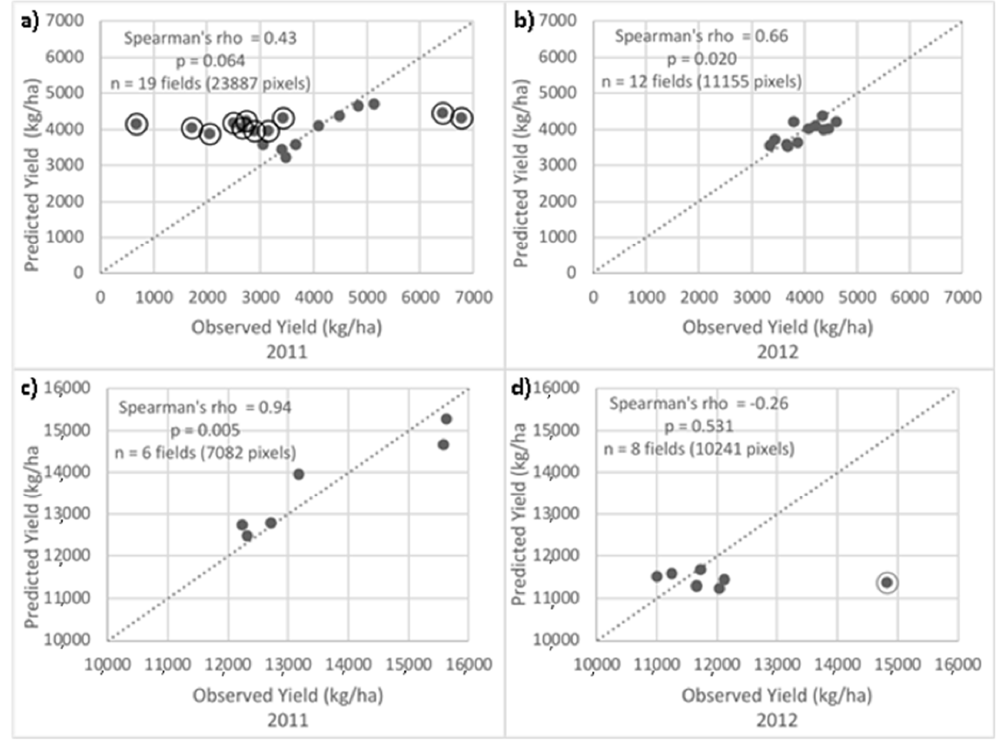
Figure 8. Correlations among predicted and observed average field yield for soybean in 2011 ( a ) and 2012 ( b ) and corn in 2011 ( c ) and 2012 ( d ). Results show the correlations from the models that were trained and tested with one crop, in one year. The circled dots in panel ( a ) and ( d ) refer to the fields with an RMAE greater than